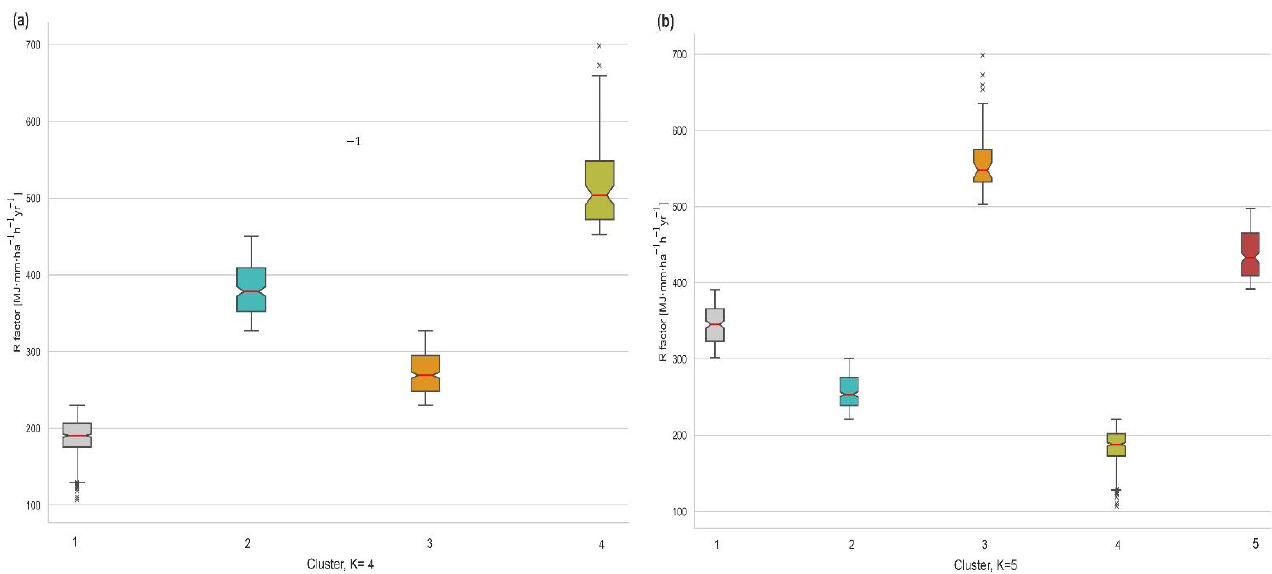
Figure 8. k-means clustering of R-factors calculated by the RUSLE methodology when ( a ) K = 4 and ( b ) K = 5. Light grey dotted lines present R-factor values >400 mm ha − 1 h − 1 yr − 1 , and dark grey dotted lines are R-factor values >600 mm ha − 1 h − 1 yr − 1 .